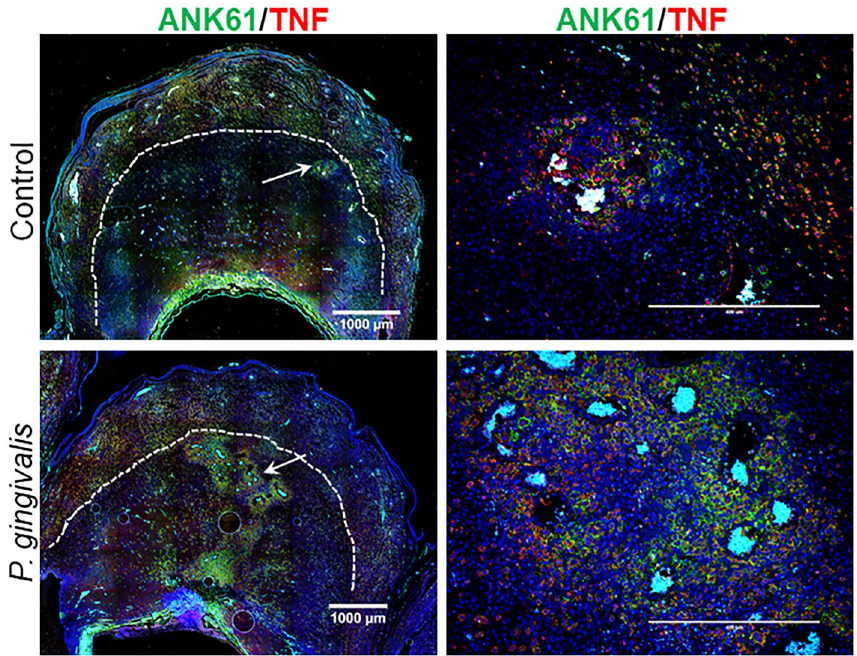
Figure 5. In situ distribution of uNK cells in control and P. gingivalis -infected specimens collected at GD11. uNK cells were identified with an antibody to Ank61 (green), some of which are also positive for TNF (red). Left panels are tiled composites of individual pictures taken at × 10 magnification with an EVOS Auto FL imaging system. Scale bar = 1000 µm. Dashed lines demarcate the junction between decidua and myometrium. White arrows mark the spiral artery segments pictured in corresponding magnified images on the right (white scale bar = 200 µm). Representative images of GD18 specimens and isotype controls are found in Supplement File Fig.